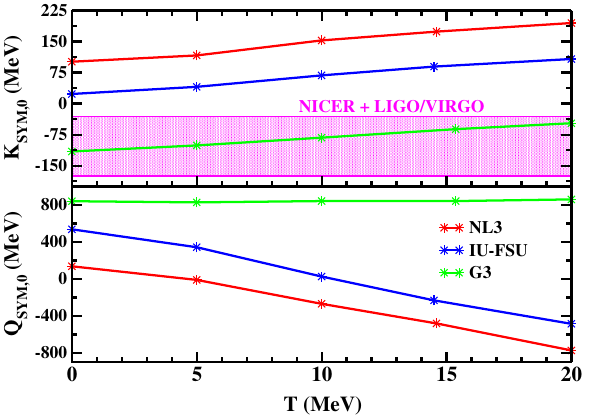
Fig. 8 Thermalindexatdifferenttemperaturesasafunctionofnucleon density for NL3 (solid line), G3 (dashed line) and IU-FSU (dotted) parameter sets. T C is the critical temperature for the corresponding parameter set